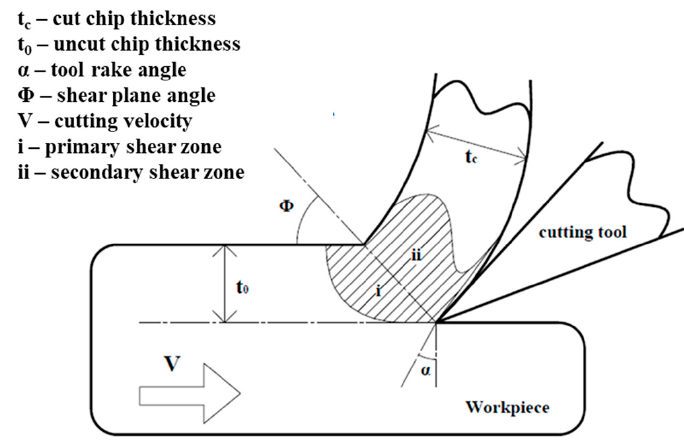
Figure 2. Schematic of orthogonal machining process.